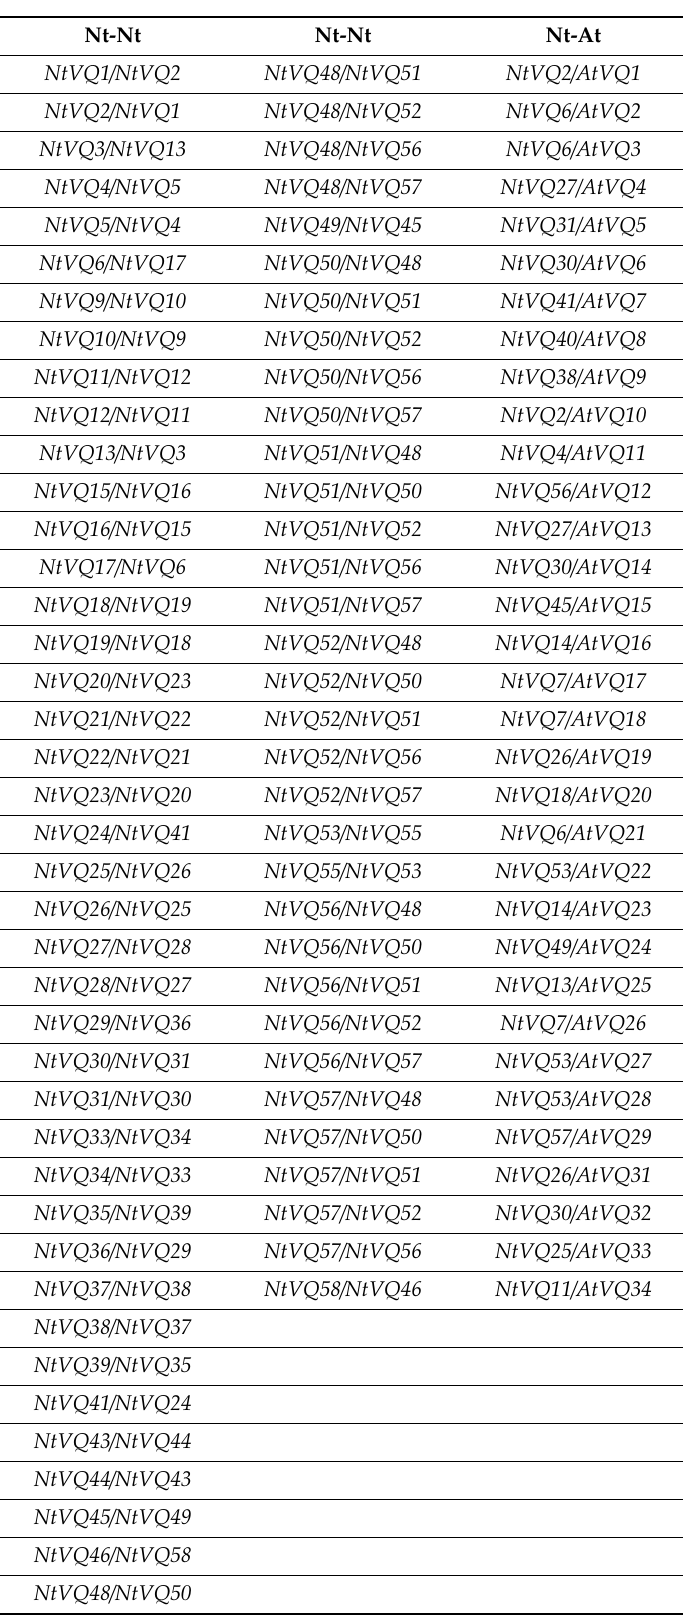
Table 1. Paralogous (Nt-Nt) and orthologous (Nt-At) gene